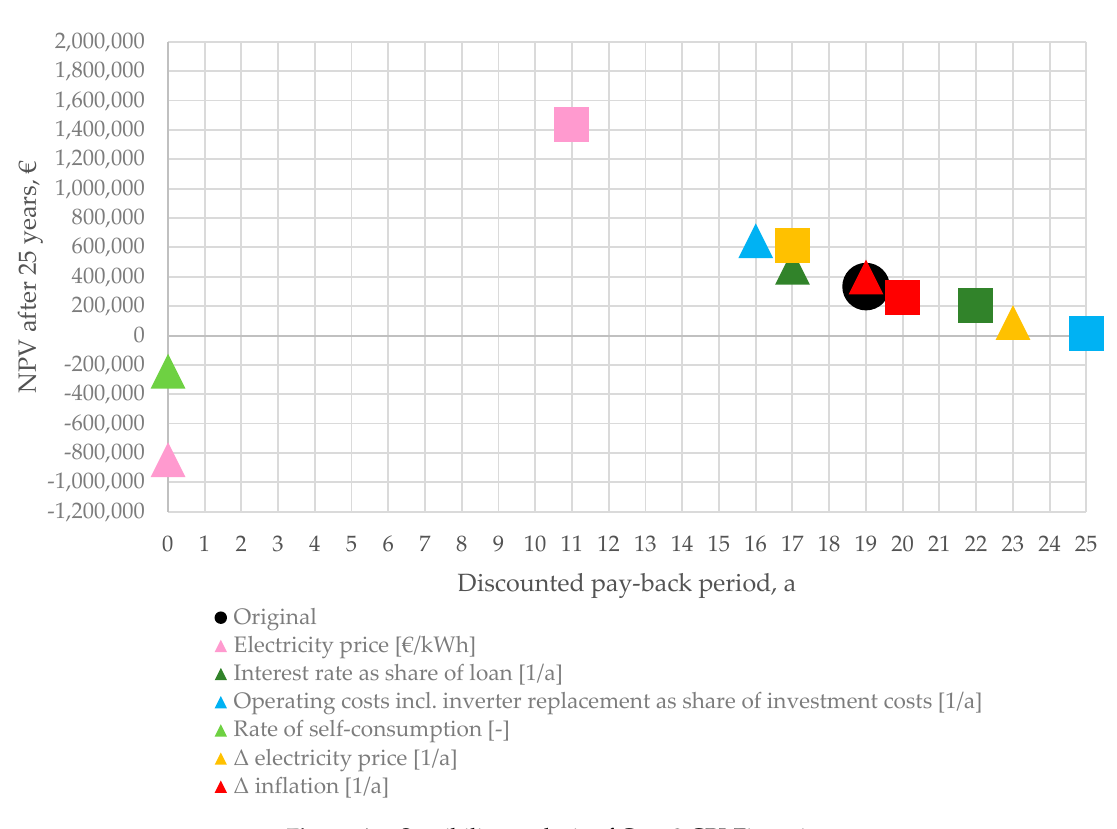
Figure A6. Sensibility analysis of Case 3 CPI-Financing.